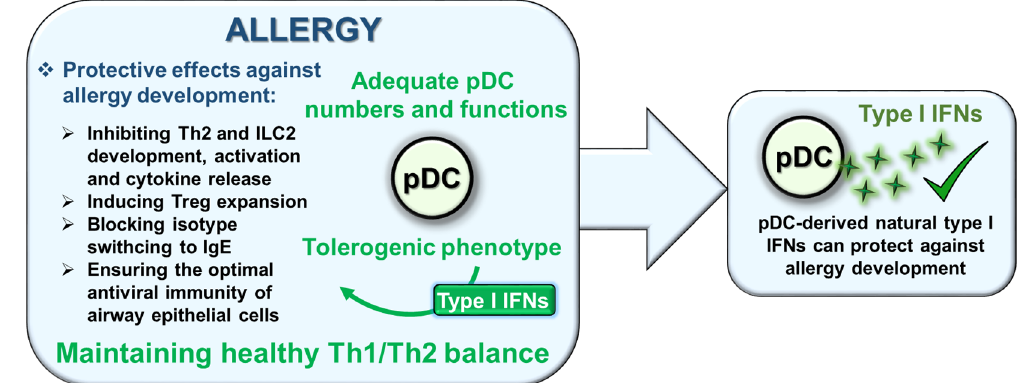
Figure 4. Role of pDC-type I IFN axis in allergy. PDCs have a protective role in the development of allergic diseases via secreting type I IFNs, which help to maintain a healthy Th1–Th2 balance and prevent the shift towards Th2 dominance in the airways. IFN: interferon; IgE: immunoglobulin E; ILC2: type 2 innate lymphoid cells; pDC: plasmacytoid dendritic cell; Th: T helper; Treg: regulatory T cell.